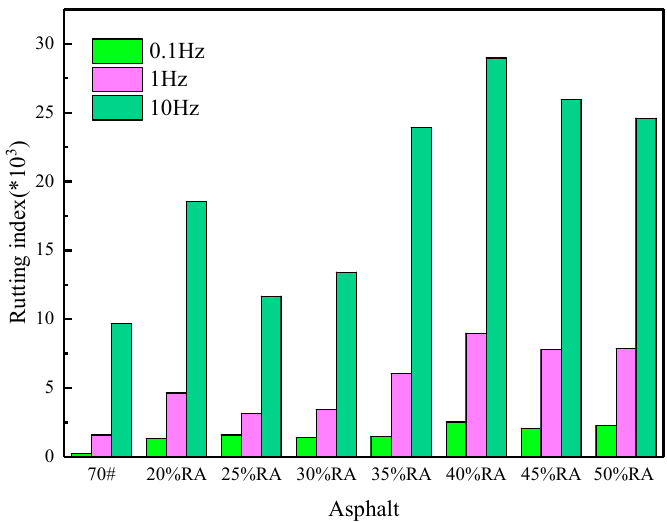
Figure 8. Rutting index of high-content rubberized asphalt.